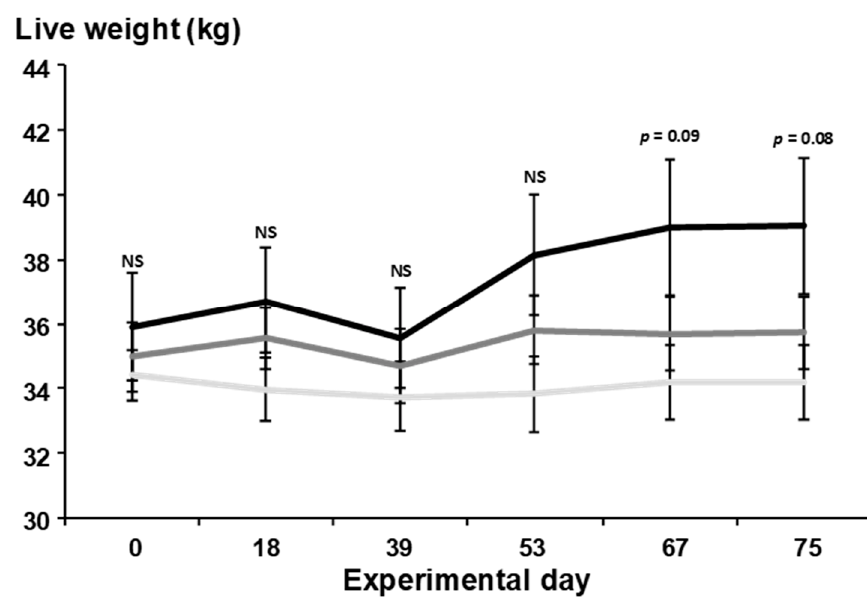
Figure 1. Effects of substituting sorghum stubble for T. recurvata on goat live weight. Mean live weight from 0 d to d 75 of the experimental period from multiparous mixed-breed goats that received 0% (T0; solid black line), 30% (T30; solid dark grey line), or 60% T. recurvata (T60; solid light grey line) in the diet. NS = non-significant. Values are means ± SEM .